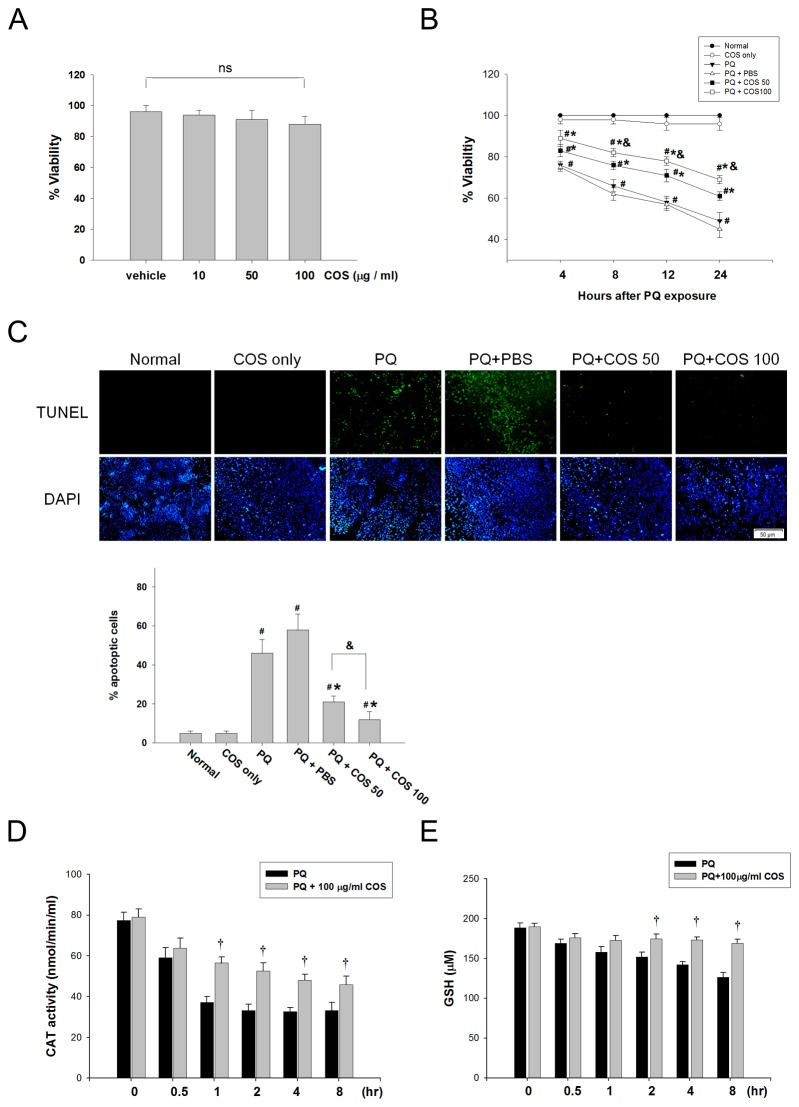
The influence of COS on PQ-induced cell death, apoptosis and antioxidative enzyme in RGC-5 cells.(A) Effects of COS on RGC-5 viability determined by MTT assays. RGC-5 cell were incubated for 24 h with vehicle or COS at indicated concentrations. (B) COS decreased PQ-stimulated RGC-5 cell death. RGC-5 cell were stimulated with 0.5 mM PQ and treated with 50 or 100 μg/ml COS for indicated time. (C) Inhibition by COS of PQ-induced apoptosis. RGC-5 cell were stimulated with 0.5 mM PQ and treated with 50 or 100 μg/ml COS or PBS for 6 hours. Cells apoptosis was analyzed by TUNEL stain. Percent apoptotic RGC-5 cells were obtained by counting at least 400 cells. Data were expressed as mean ± SD. ns, Non-significant compared with vehicle-treated control. (*P < 0.05 compared with PQ only or PBS-treated group; # P < 0.05 compared with normal; & P< 0.05 by ANOVA with post hoc Bonferroni test; N=3 in each group) (D) COS activated catalase activity in PQ-stimulated RGC-5. RGC-5 cell were stimulated with 0.5 mM PQ and treated with 100 μg/ml COS for indicated time. (E) COS increased GSH levels in PQ-stimulated RGC-5. (†P < 0.05 compared with PQ only by Student’s t-test; N=3 in each group).